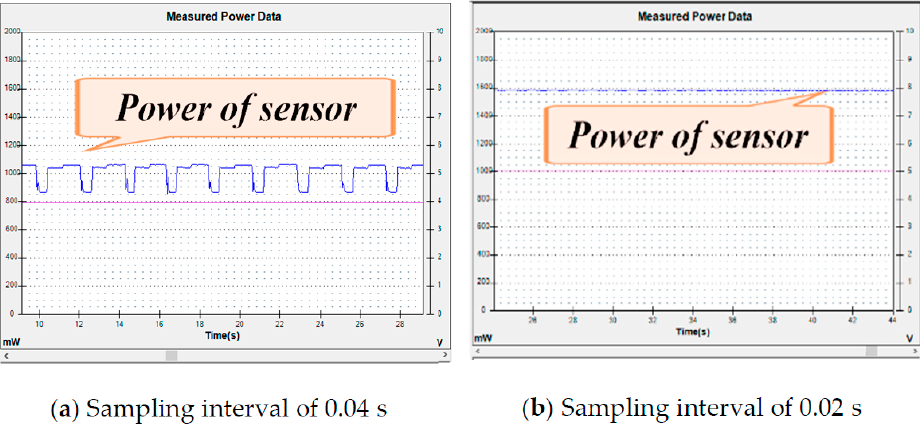
Figure 12. Power of the sensor system.